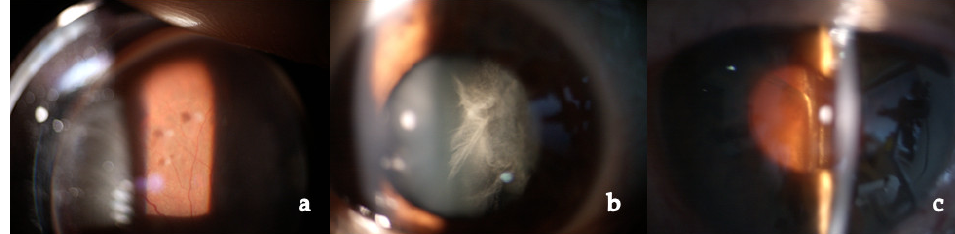
Figure 15. Different aspects of intermediate sarcoid uveitis. Snowballs ( a ); acute inflammatory vitreitis ( b ); chronic vitreitis ( c ).